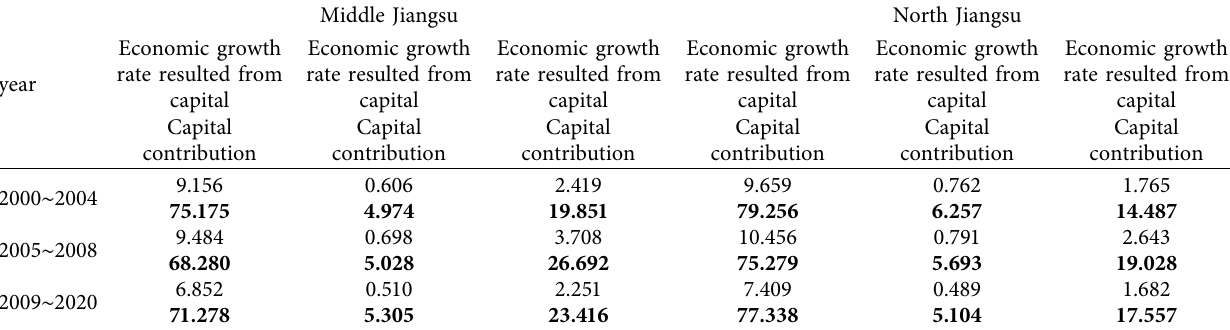
Table 5: :The formation features of urban economic development driving force in Middle Jiangsu and North Jiangsu from 2000 to 2020. Middle year